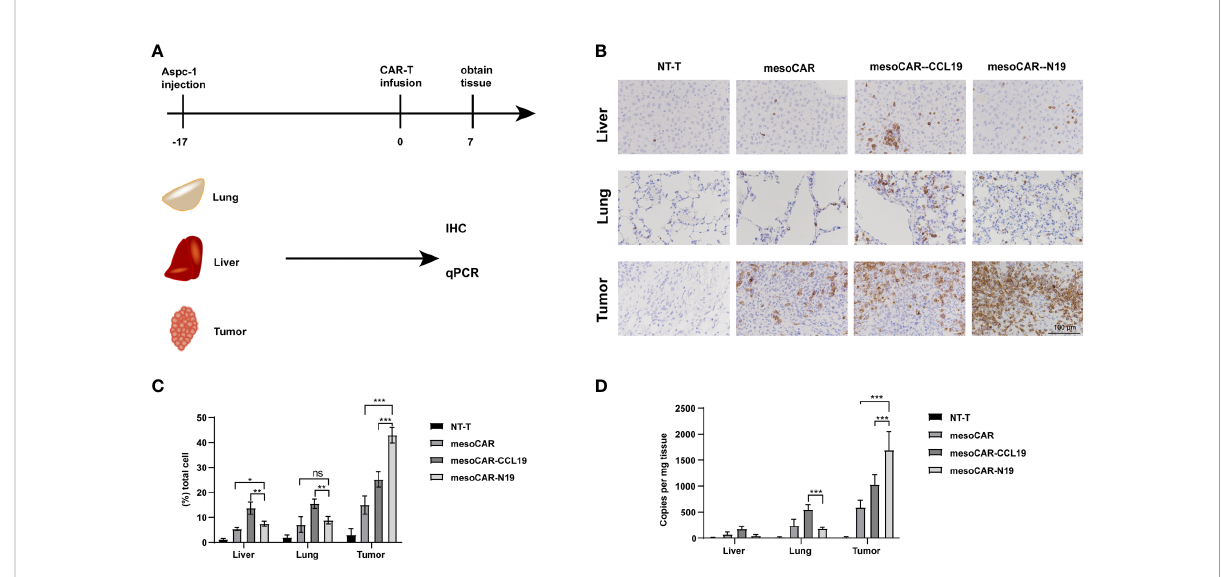
FIGURE 7 Chimeric antigen receptor (CAR) T (CAR-T) cell in fi ltration and distribution. (A) Schematic diagram of experimental design; (B) Immunohistochemical staining of hCD3 and (C) quanti fi cation; (D) Detection of CAR gene copy numbers by quantitative PCR. Error bars represent the mean ± standard deviation (n = 6).*P<0.05; **P<0.01; ***P<0.001; ns, no signi fi cance.